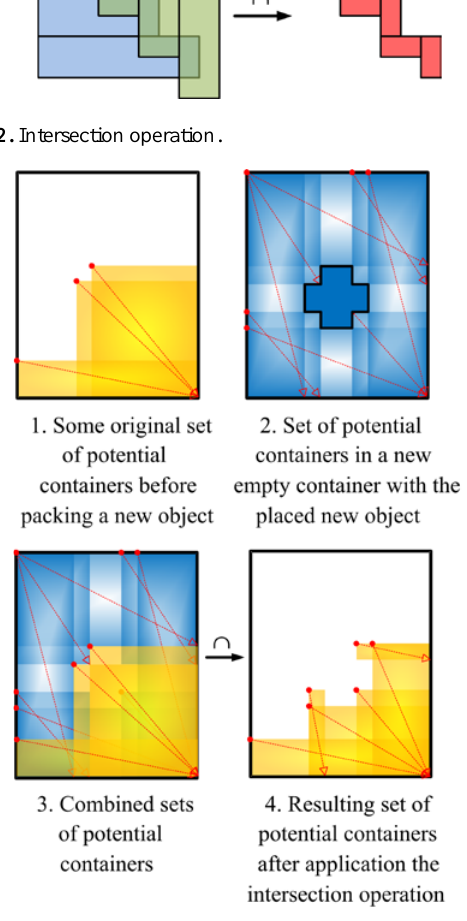
Fig. 3. Updating of potential containers